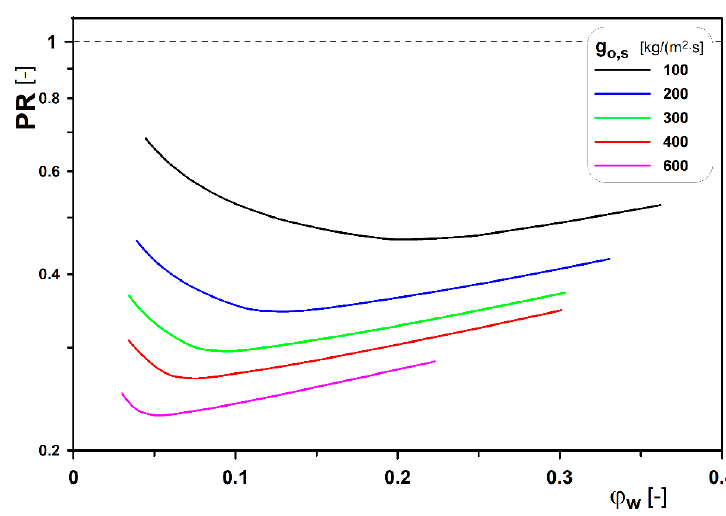
Figure 10. Variations in PR index for oil with the viscosity η r =300.